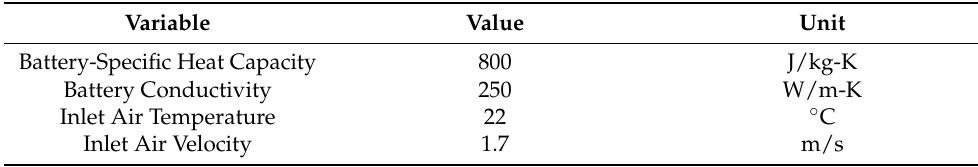
Table 2. Input variables used within experimental model simulation. Variables pertaining to air flow were measured from experimental model trials. Variable Value